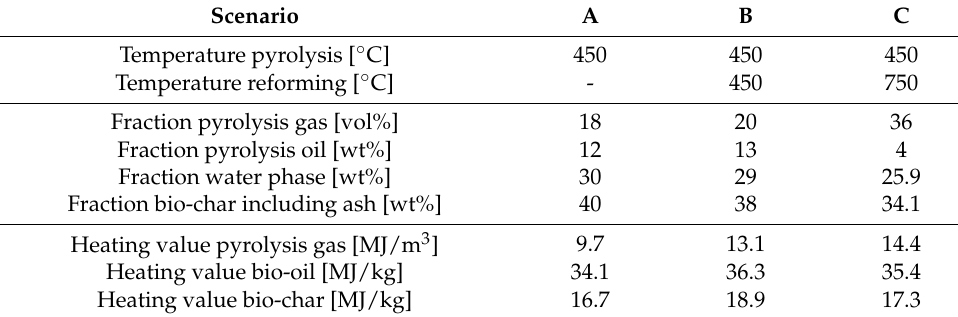
Table 2. Product yields of the TCR ® process (biogas digestate)